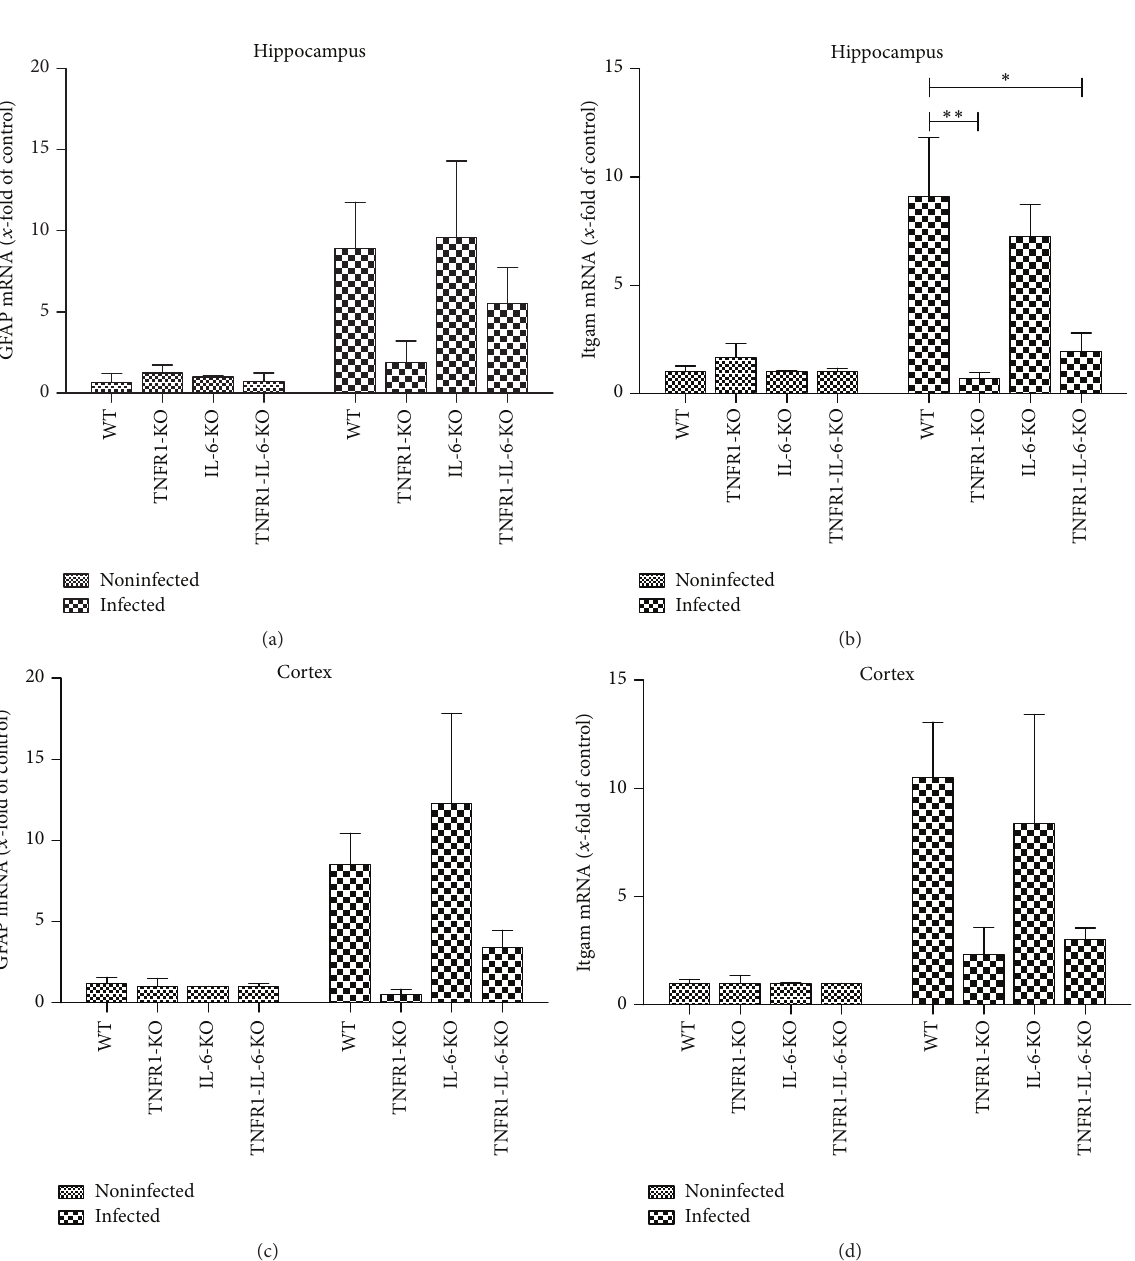
Figure 3: Gene expression of glial cell marker after pneumococcal meningitis. Analysis of astrocyte marker GFAP mRNA expression (a and c) and microglia marker Itgam (b and d) in the hippocampal formation and cortex of TNFR1-, IL-6-, or TNFR1-IL-6-KO and WT mice 30 h after induction of pneumococcal meningitis by real-time RT-PCR were assessed from five independent experiments in duplicate. The asterisk indicates a significant difference between infected WT and infected TNFR1- or TNFR1-IL-6-KO mice as determined by ANOVA followed by Bonferroni test ( ∗ 𝑝 < 0.05 ; ∗∗ 𝑝 < 0.01